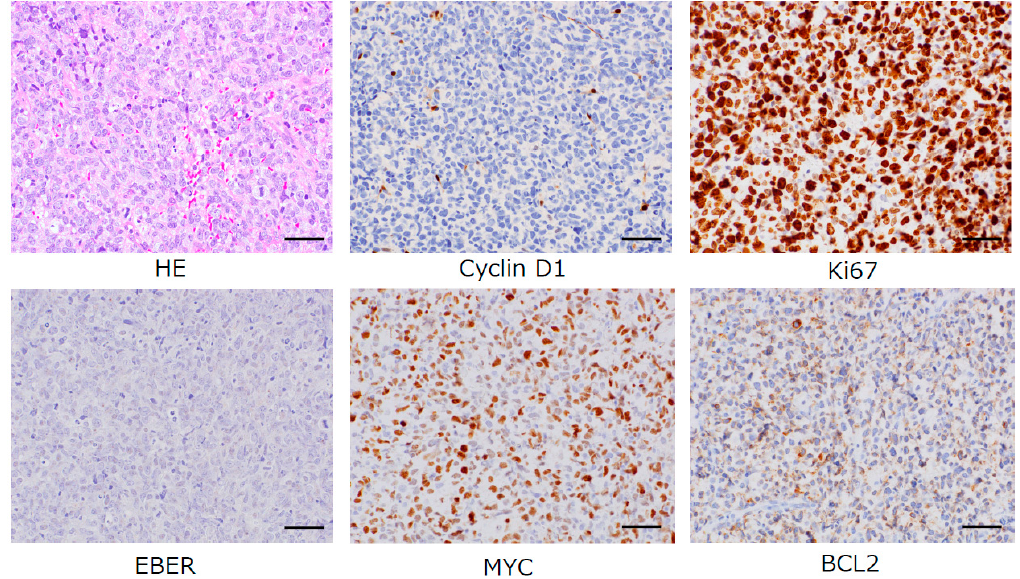
Figure 4. Diffuse infiltration of neoplastic large B cells (HE, magnification 200×, bar = 100µm) with negative cyclin D1 immunostaining (magnification 200×, bar = 100µm) was recognized. Immunostaining of Ki67 (90% of neoplastic cells, magnification 200×, bar = 100µm), BCL2 (40% of neoplastic cells, magnification 200×, bar = 100µm), and MYC (60% of neoplastic cells, magnification 200×, bar = 100µm) showed positive reaction for these antibodies. Epstein–Barr virus (EBV)-associated diffuse large B cell lymphoma (DLBCL) was not recognized, as Epstein–Barr virus encoded RNA (EBER) in situ hybridization was negative (magnification 200×, bar = 10µm). The morphologic, immunophenotypic, and molecular / genetic features allowed for the identification of a prognostically important subtype: activated B-cell (ABC)-DLBCL with the co-expression of MYC /